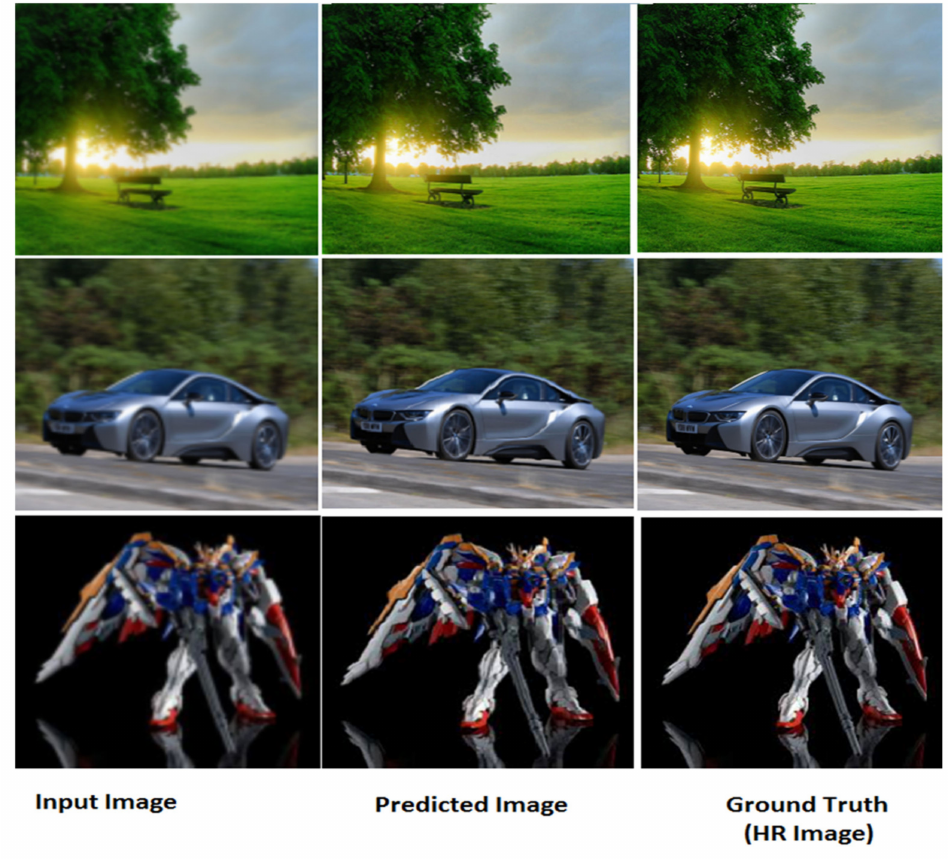
Figure 18. Input, Prediction, and Ground truth (high-resolution) image of ResNet-based